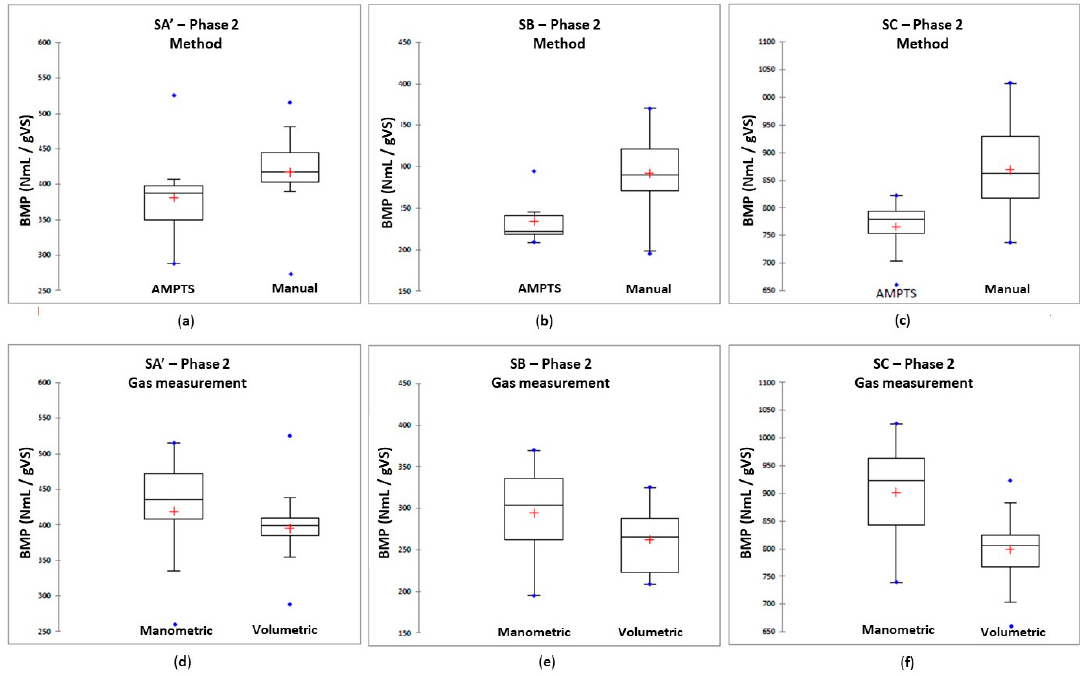
Figure 9. Box plots for the variables Method ( a – c ) and Gas measurement ( d – f ) for SA’, SB and SC. Table 9. ANOVA with 4 factors for SA’, SB and SC.